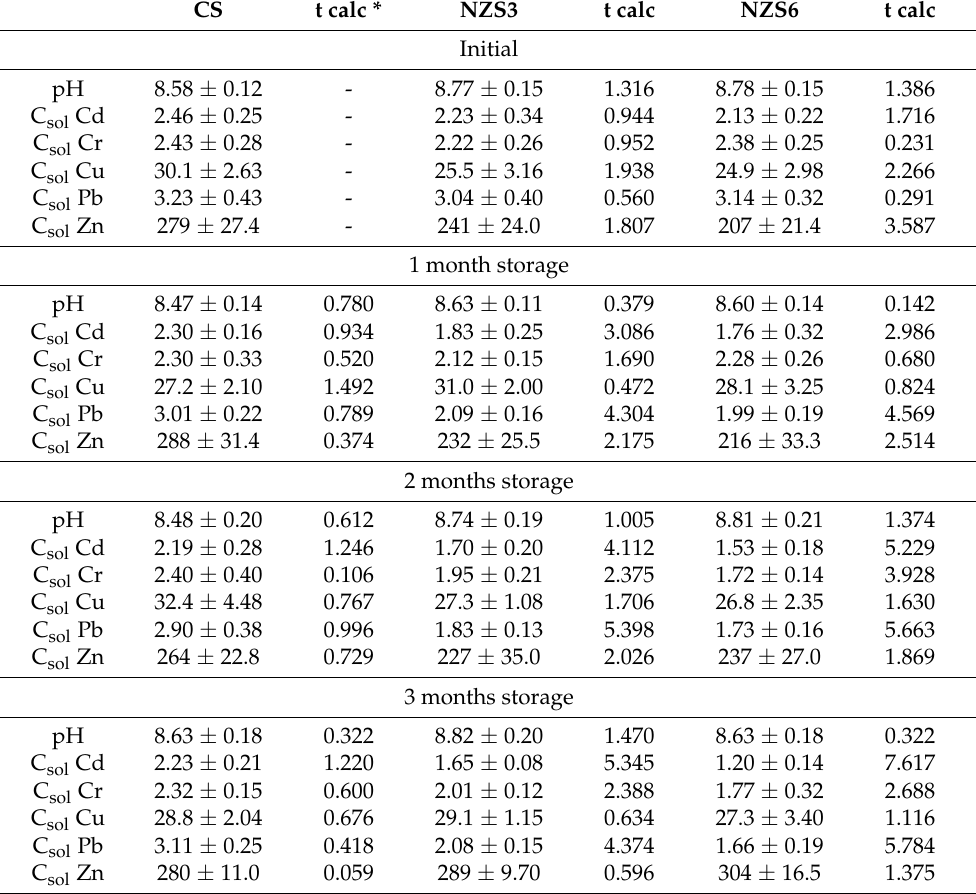
Table 2. Heavy metal concentrations ( µ g L − 1 ) in soil solution (C sol ) and pH of control soil (CS) and mixtures with zeolite (NZS3 and NZS6) during the three-month storage (average ± standard deviation, n = 3 parallel